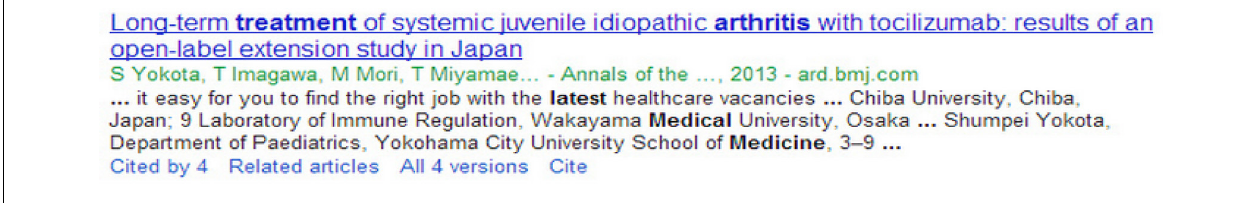
FIGURE 2 | Example document